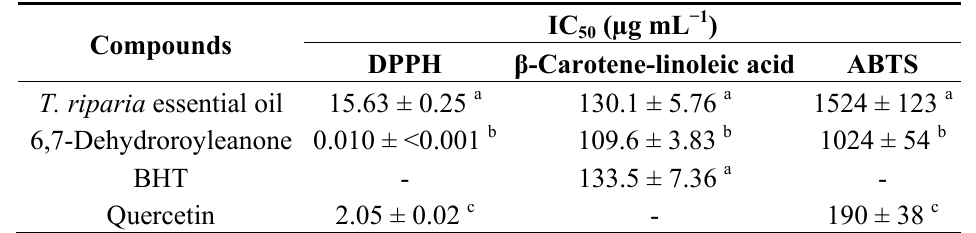
concentration (Inhibitory Concentration; IC50; µg mL − 1 ) for T. riparia essential oil and isolated compound 6,7-dehydroroyleanone using three different methods: DPPH radical scavenging, β -carotene-linoleic acid or ABTS [2,2'-azinobis-(3-ethylbenzothiazoline-6- sulfonic acid)]